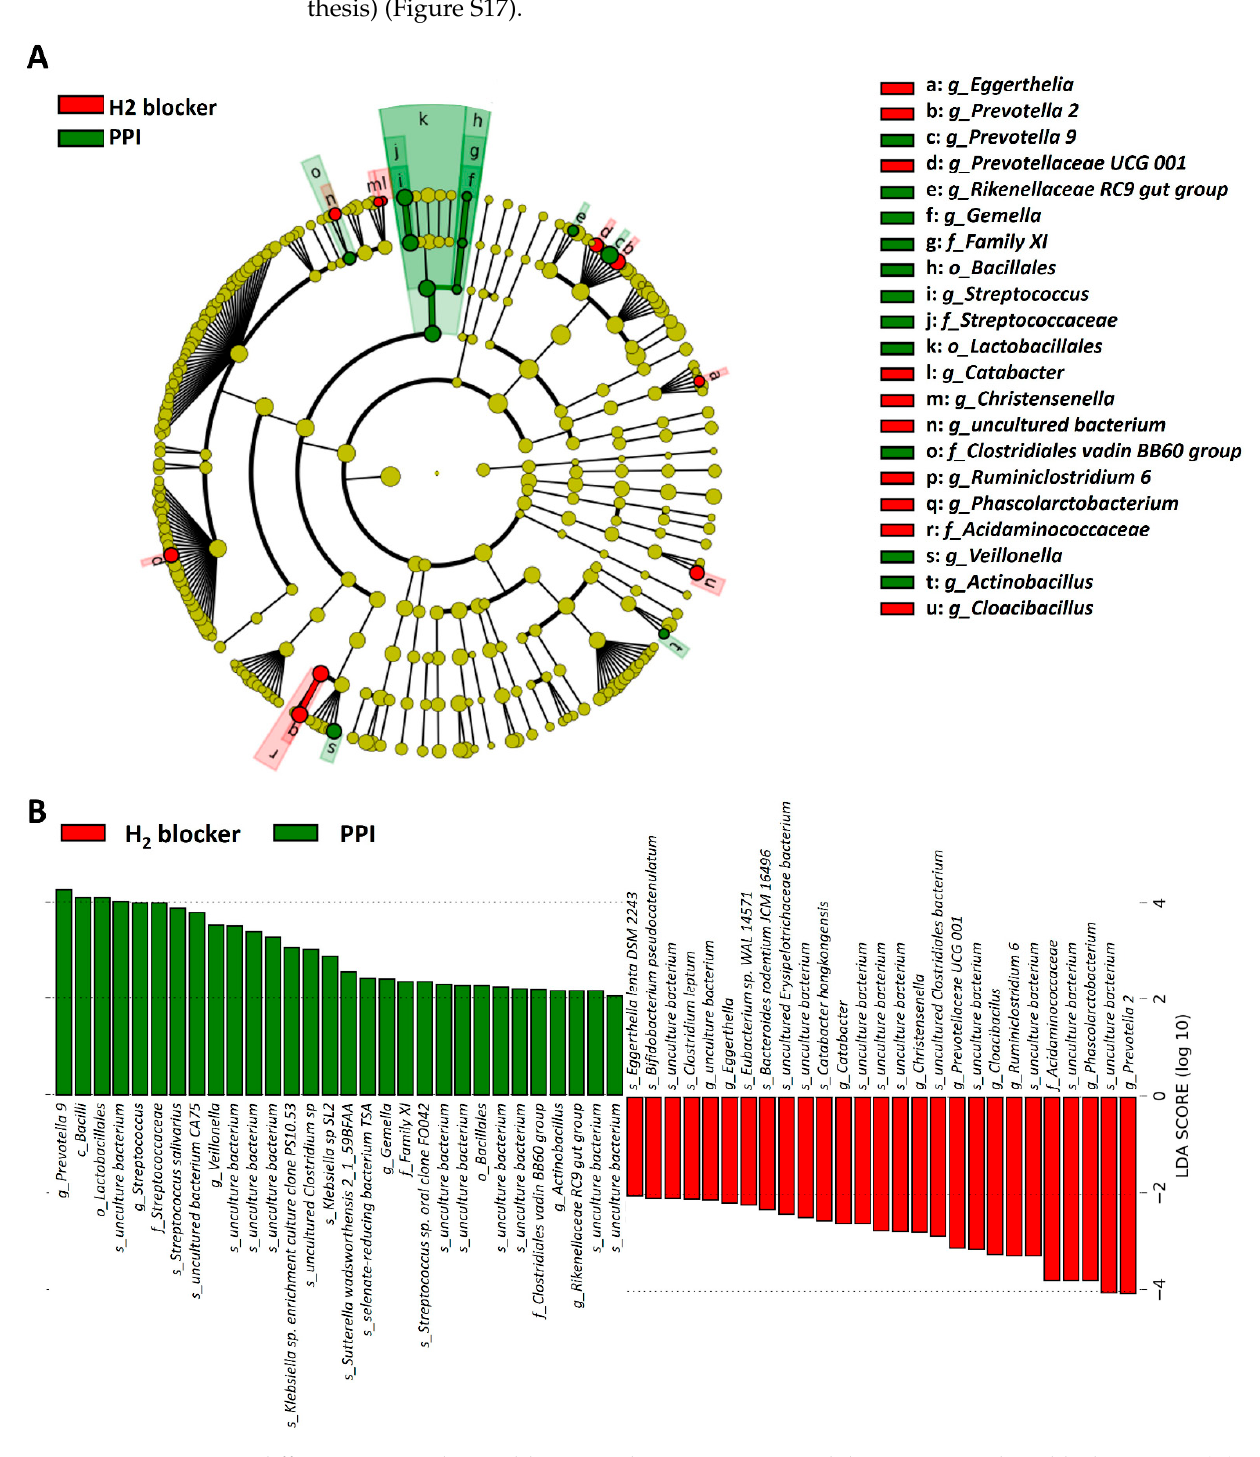
Figure 6. Taxonomic differences were detected between the proton pump inhibitor users and H 2 -blocker users: ( A ) cladogram showing differentially abundant taxonomic clades with an LDA score > 4.0 among PPI users and H 2 -blocker users; ( B ) linear discriminative analysis (LDA) effect size (LEfSe) analysis between proton pump inhibitor users (green) and H 2 -blocker users (red).